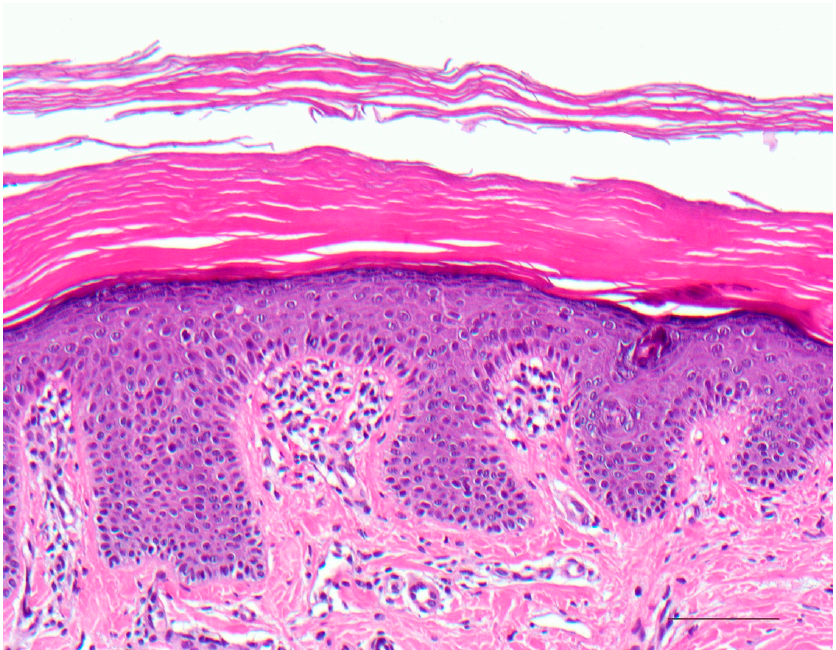
Figure 4. Autosomal recessive lamellar ichthyosis. Acanthotic epidermis with well-developed stratum granulosum and compact orthohyperkeratosis without further signs of inflammation. HE stain, original magnification, bar = 100 µm.